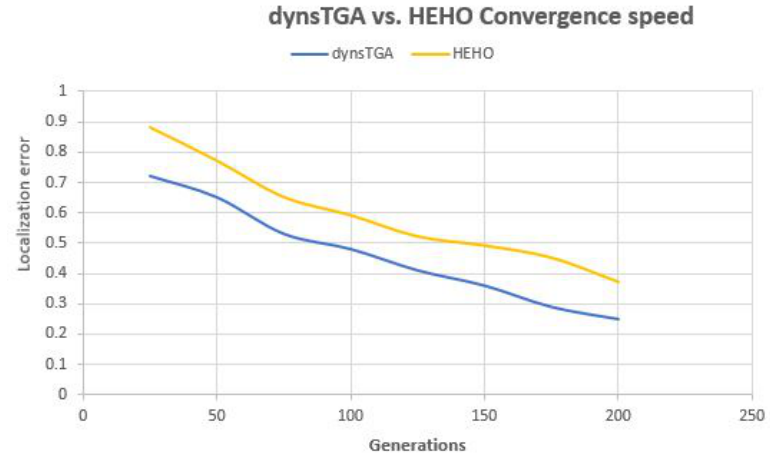
Figure 6. Convergence speed—dynsTGA vs. HEHO (50 targets and 15